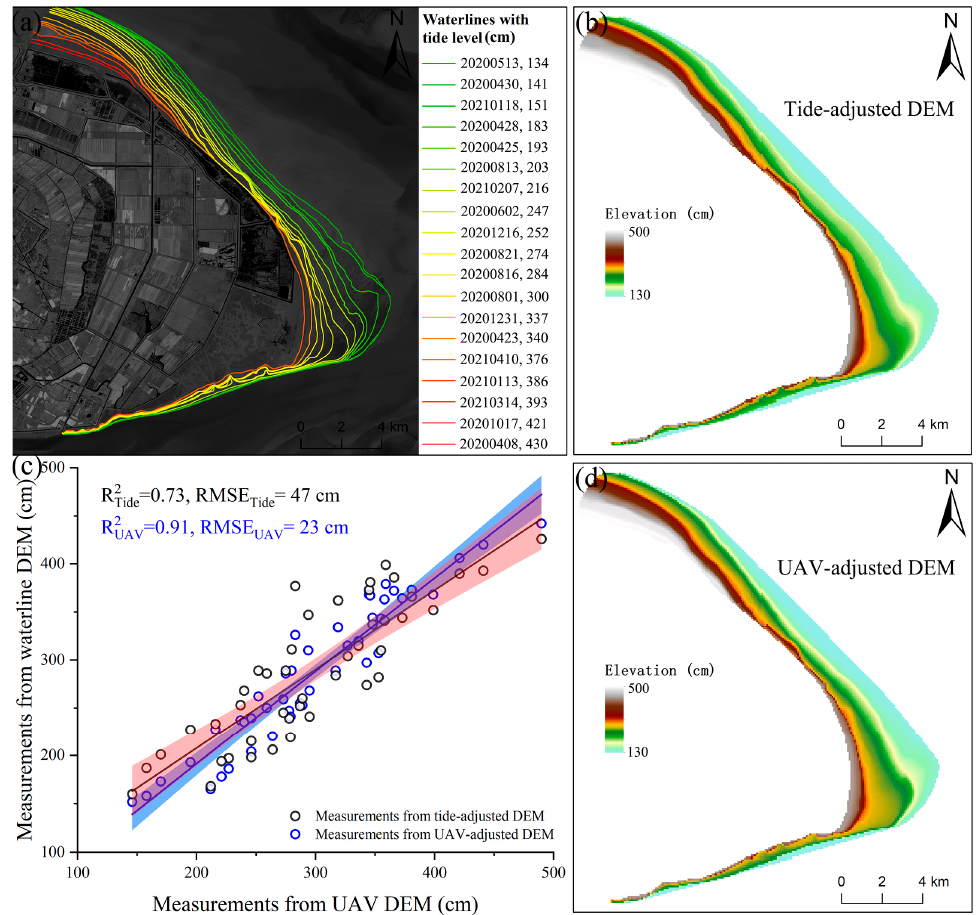
Figure 9. Mudflat DEM derived from the satellite-based waterline method: ( a ) A series of waterlines digitized from Sentinel-2 images; ( b ) DEM generation using tide levels to assign waterline elevations; ( c ) comparison of DEM accuracy produced by different waterline elevation assignments; and ( d ) DEM generation using UAV-based SfM profile to assign waterline elevations.